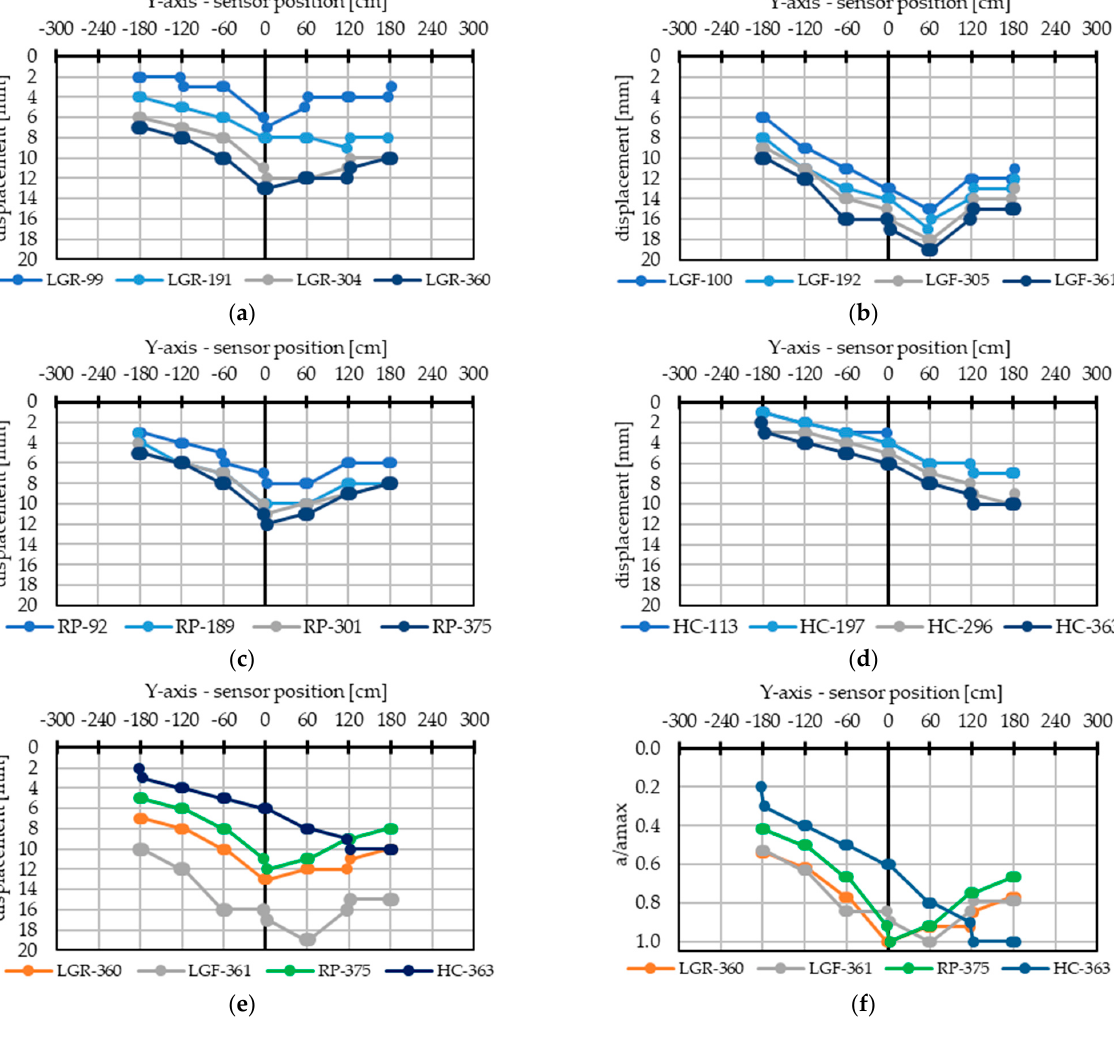
Figure 18. Displacement in the Y-axis during the load period for slabs made of ( a ) lattice girder panels with rebars; ( b ) lattice girder panels with fibre reinforcement; ( c ) prestressed ribbed panels; ( d ) hollow-core panels. ( e ) Comparison of panels and ( f ) performance of panels in the Y-axis.